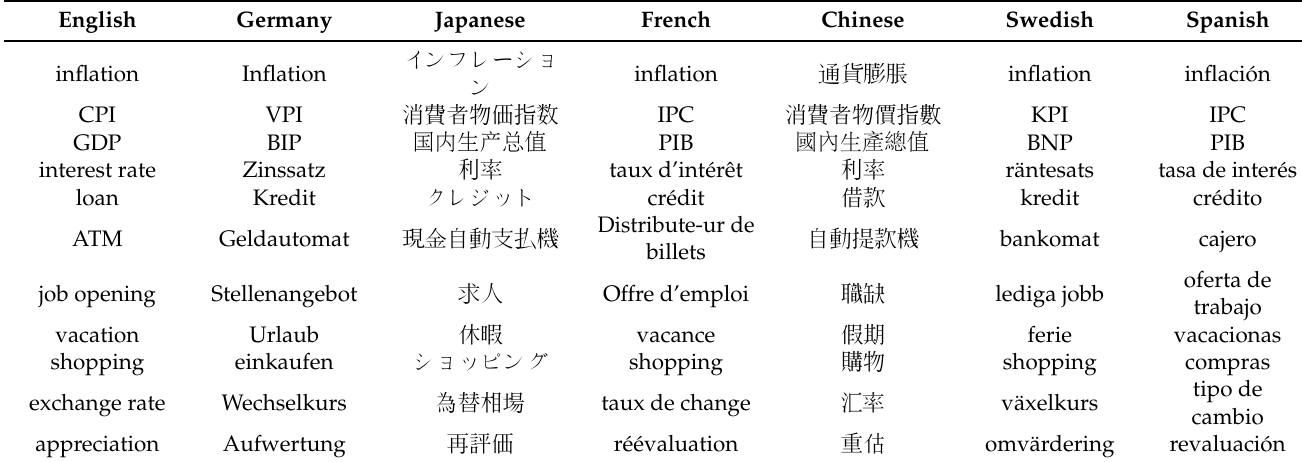
Table 1. Google Trends Keyword Selection.